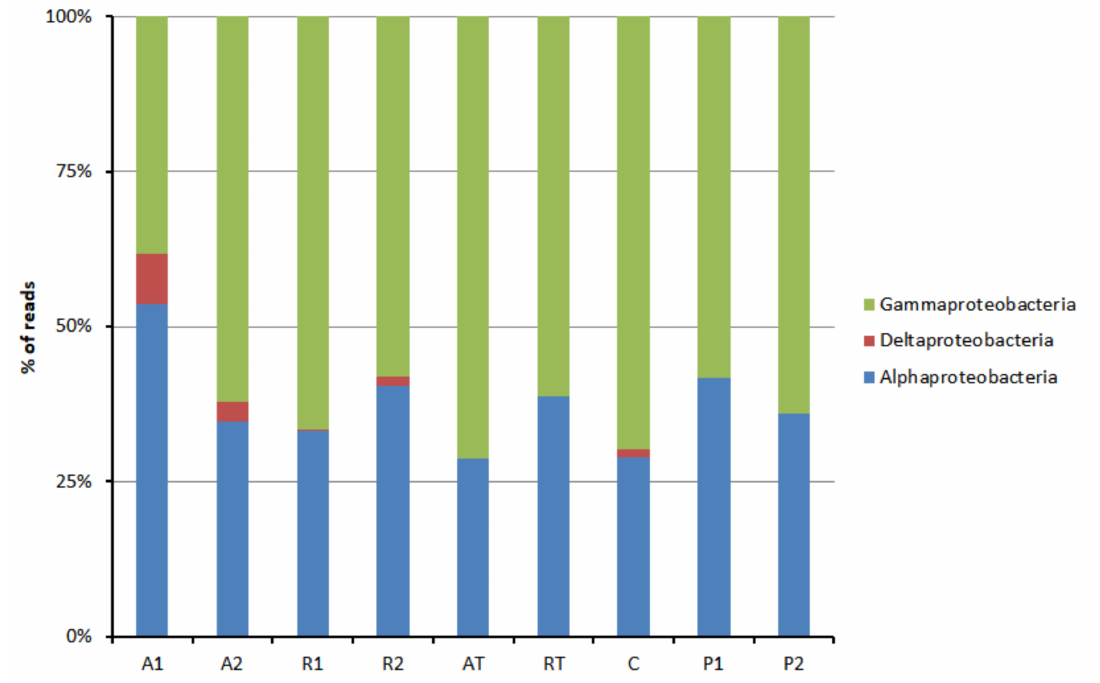
Figure 3. Class-wise distribution of phylum Proteobacteria in bee bread and bee pollen samples (A1 and A2 = bee breads collected from two colonies fed with oak pollen patty; R1 and R2 = bee breads collected from two colonies fed with rapeseed pollen patty; AT = bee bread collected from colony fed on oak pollen patty with restricted inflow of pollen from outside; RT = bee bread collected from colony fed on rapeseed pollen patty with restricted inflow of pollen from outside; P1 and P2 = bee pollen collected from bee hives equipped with pollen trap; C = bee bread collected from control hive).